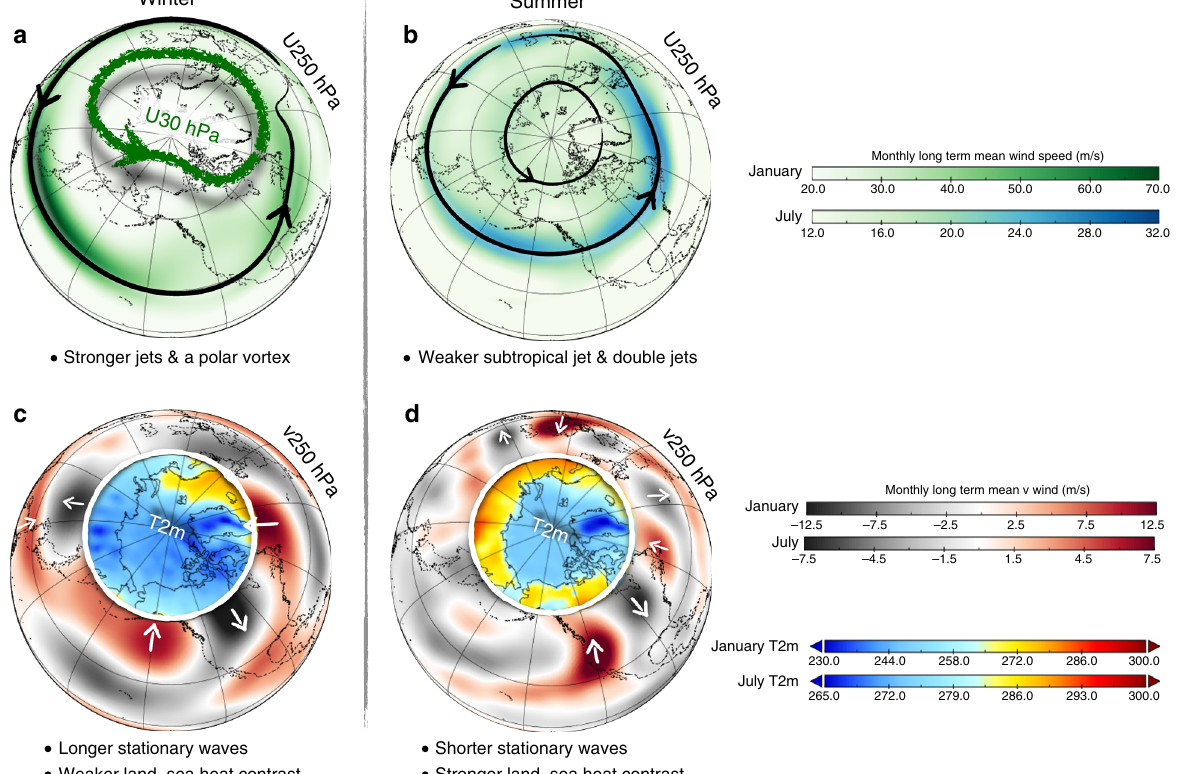
Fig. 2 Schematic fi gure illustrating the main seasonal differences in upper tropospheric circulation between winter (January) and summer (July). Panels a and b show 250-hPa wind speed (green-to-blue shading) illustrating the jet streams with black arrow lines that follow the zone of maximum wind speed. The wintertime stratospheric polar vortex is outlined with the thick green line following the 30-hPa maximum wind speed. Panels c and d show the 250 hPa meridional wind speed (dark gray-to-dark red shading) depicting the stationary wave features associated with the jet streams. White arrows are added to illustrate wind direction. Basic differences in the summer circulation features, as compared to winter, include shorter stationary waves, more northerly subtropical jet, absence of stratospheric polar vortex and an Arctic front jet forming double jets. Data are 1970 – 2000 climatology of NCEP Reanalysis